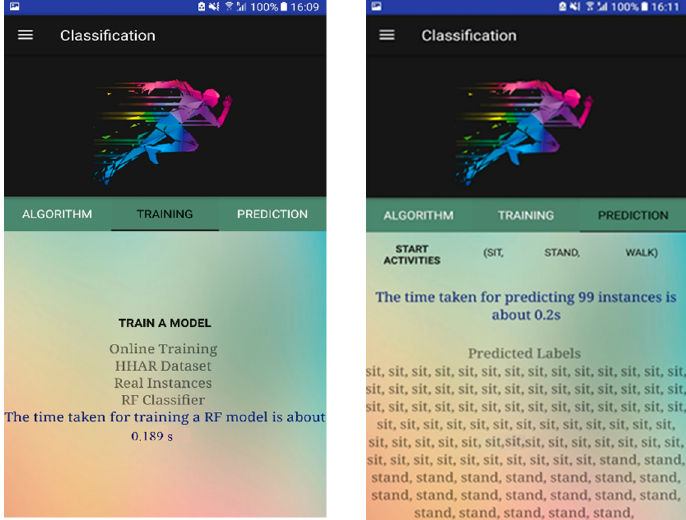
Figure 6. ARApp mobile application prototype.